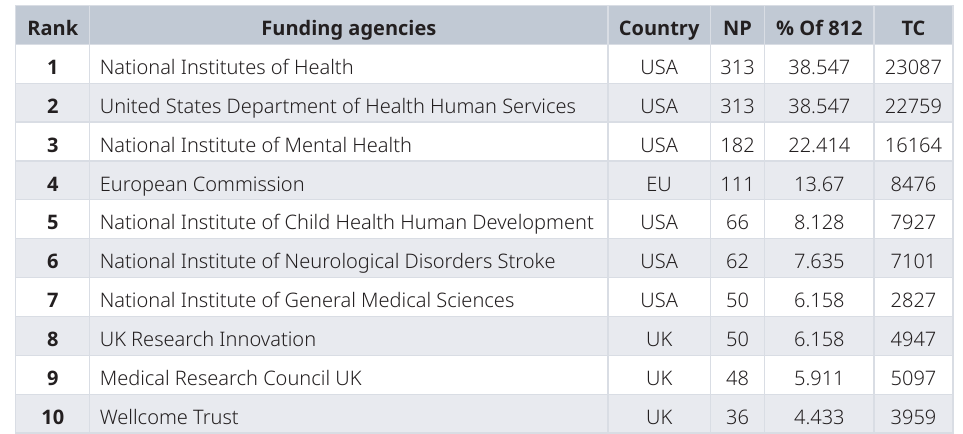
Table 9. Top ten funding agencies in autism.